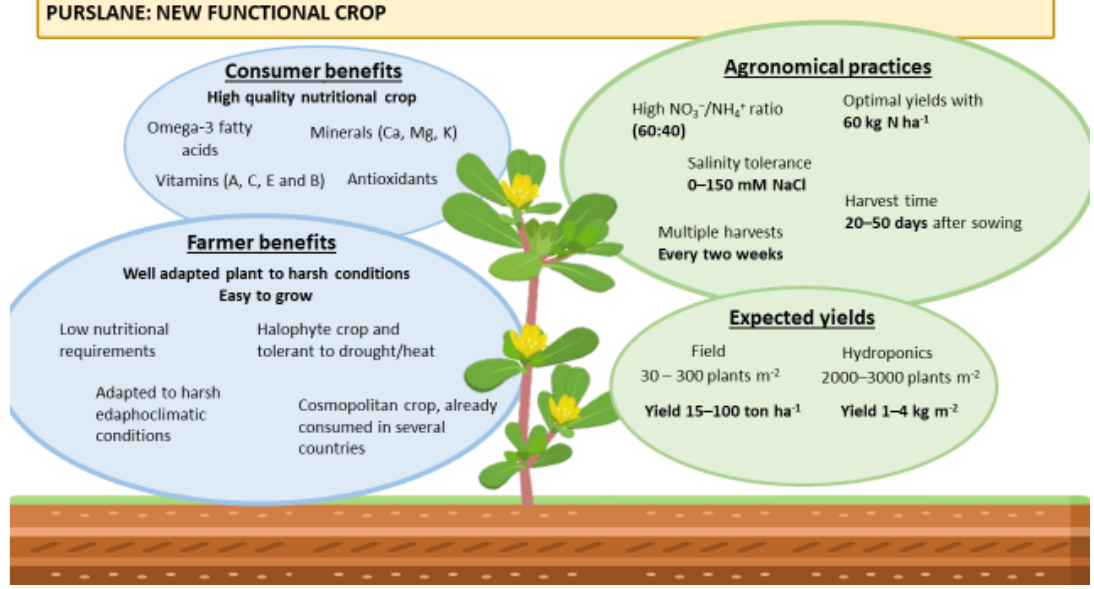
Figure 1. The concept of introducing purslane as a new functional crop.